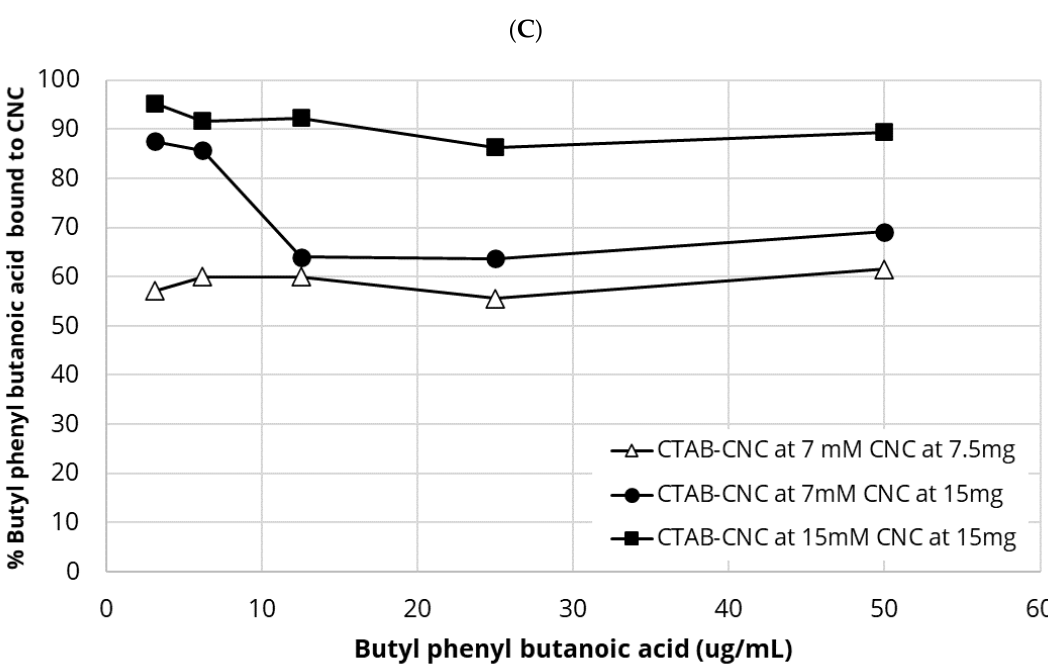
Figure 11. ( A ) Binding of butanoic acids to cationic CNC. CTAC-CNC. ( B ) Binding of naphthoxy butanoic acid to CTAB-CNC. ( C ) Binding of butyl phenyl butanoic acid to CTAB-CNC.